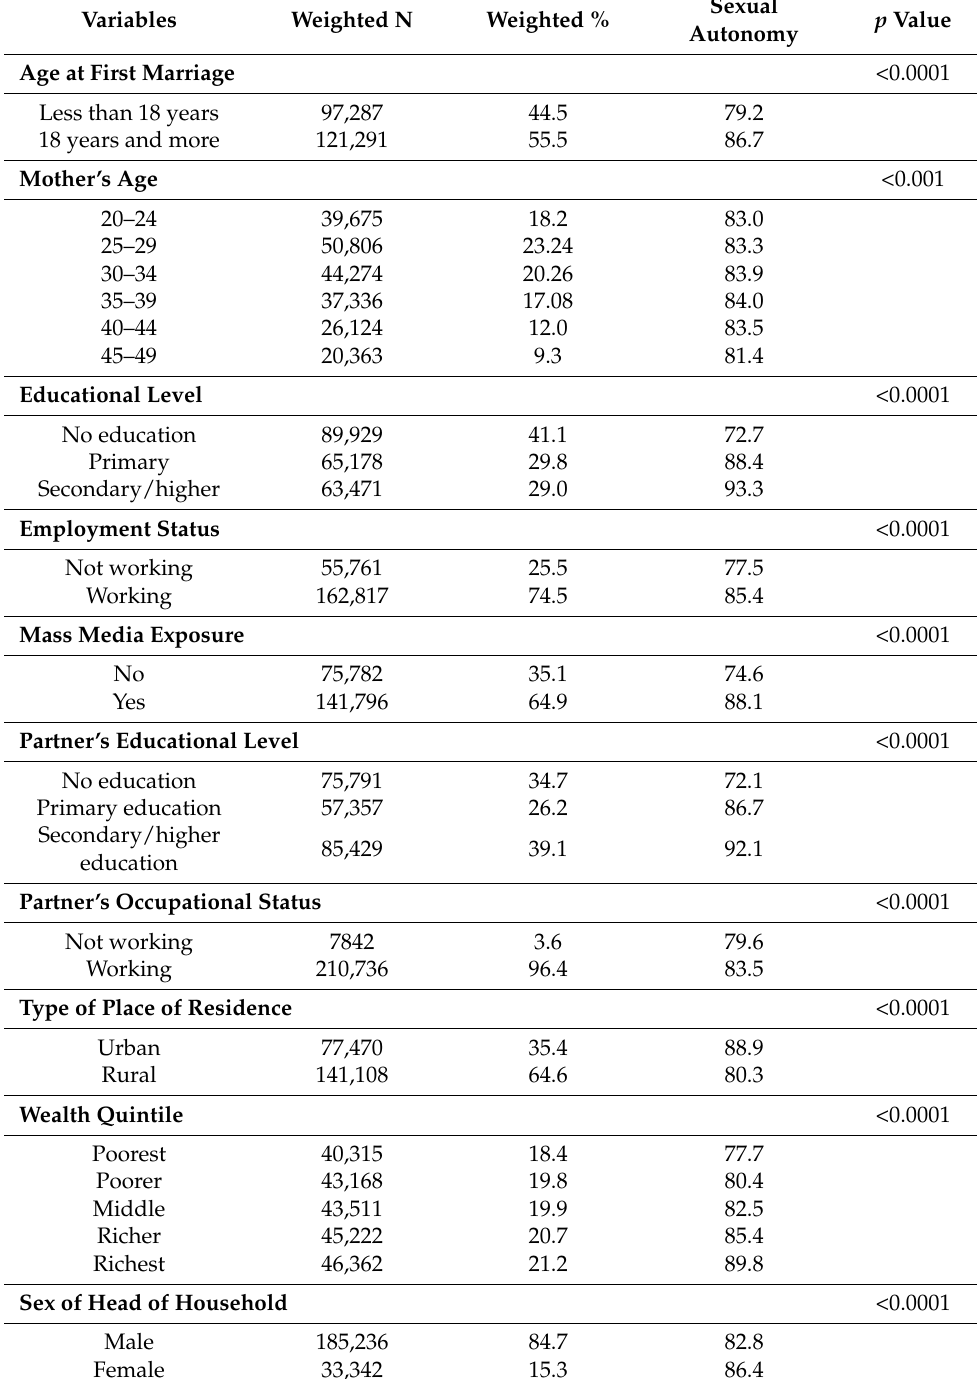
Table 2. Distribution of sexual autonomy across age at first marriage and other socio-demographic characteristics of